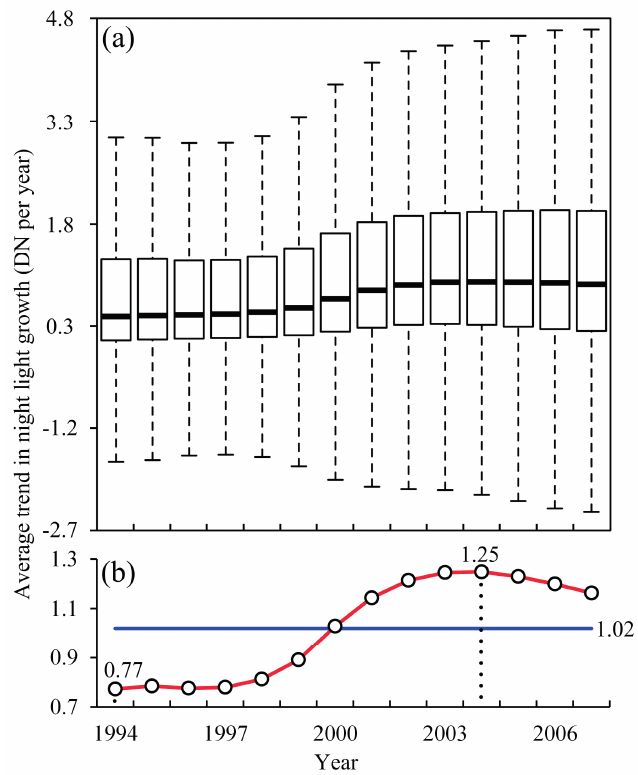
Figure 8. ( a ) Boxplot of average trend in night light growth in China from 1994 to 2007. ( b ) Comparation of trends in night light growth generated from linear model (blue) and piecewise linear model